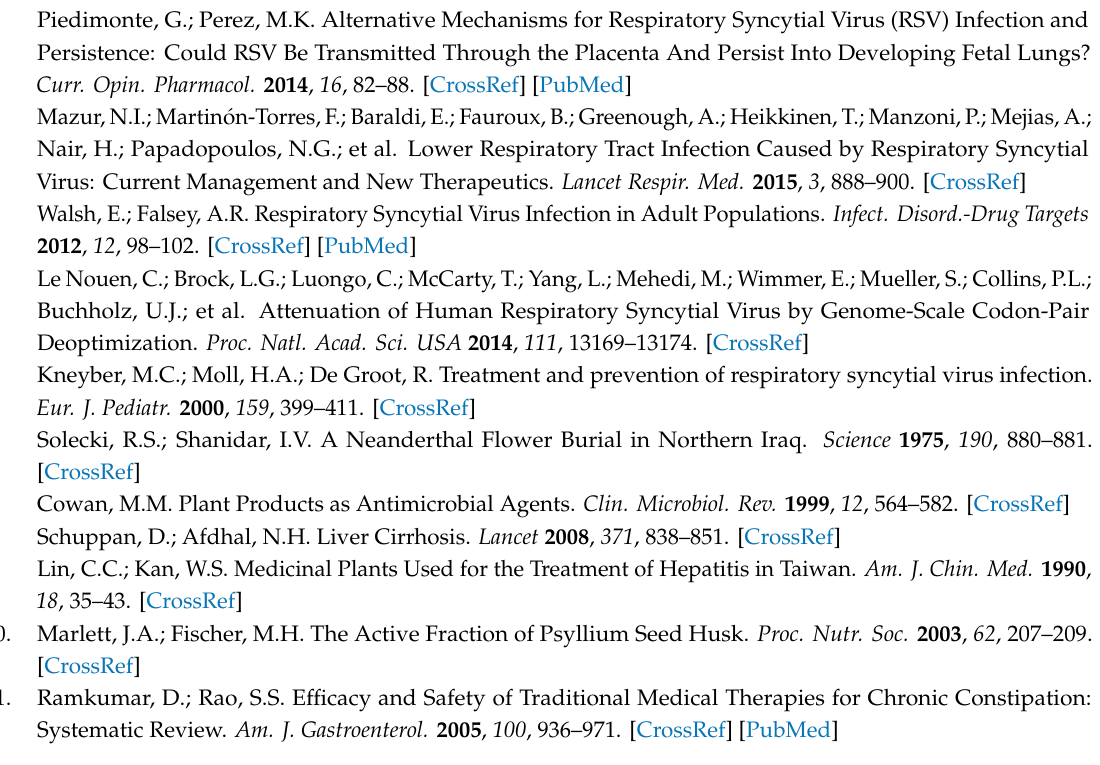
Figure S1. Herb extract library screening results, Figure S2. Selected herb extracts second round screening